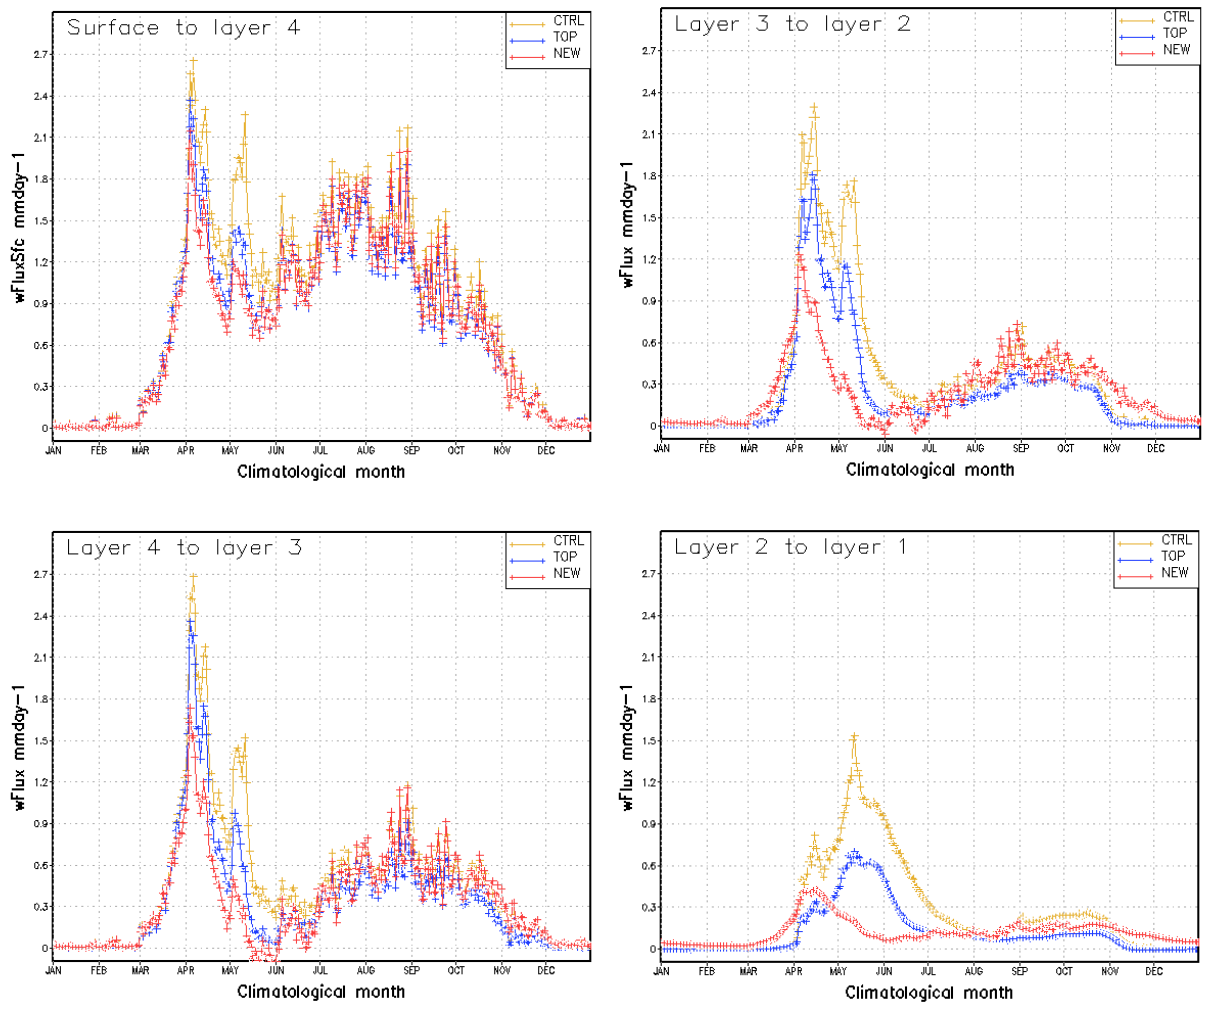
Figure 8. Daily average downward moisture fluxes within the soil column over the Ob. A plot 3 of climatological, area-average values over model runs for 1989-99.4